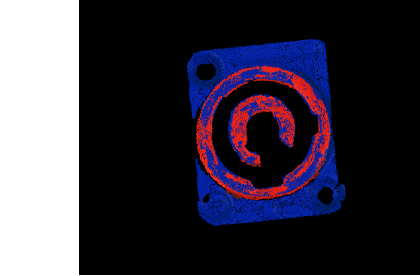
Figure 19. The effect of point cloud registration using the method proposed in this paper.